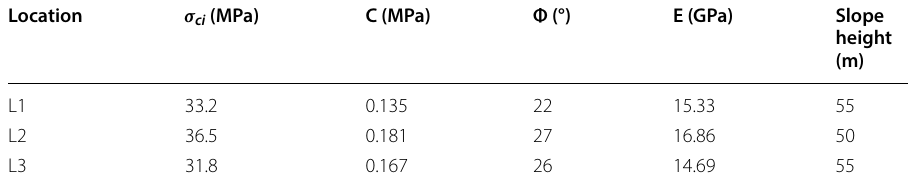
Table 8 Estimated data of representative rock samples for all locations